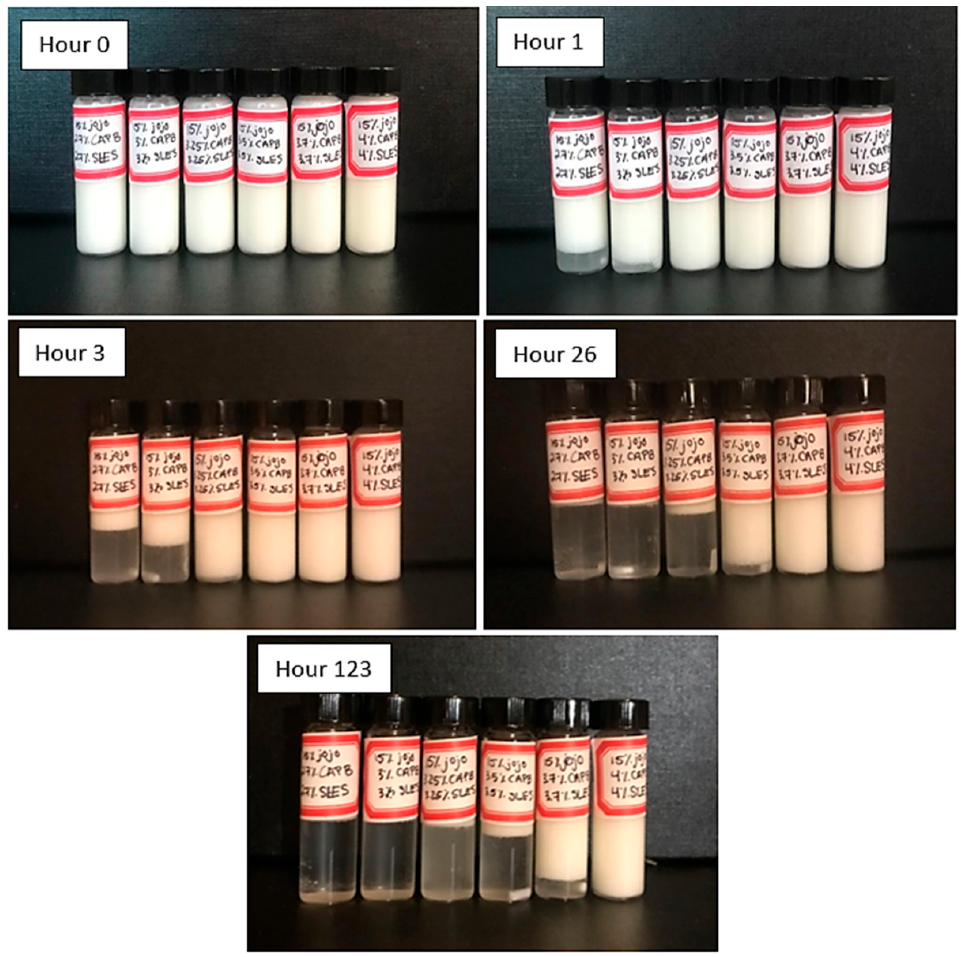
Figure 1. 15 wt % jojoba oil emulsions’ visual stability. From left to right samples are 5.4 wt %, 6 wt %, 6.5 wt %, 7 wt %, 7.4 wt %, and 8 wt % total CAPB and SLES emulsifier concentrations.